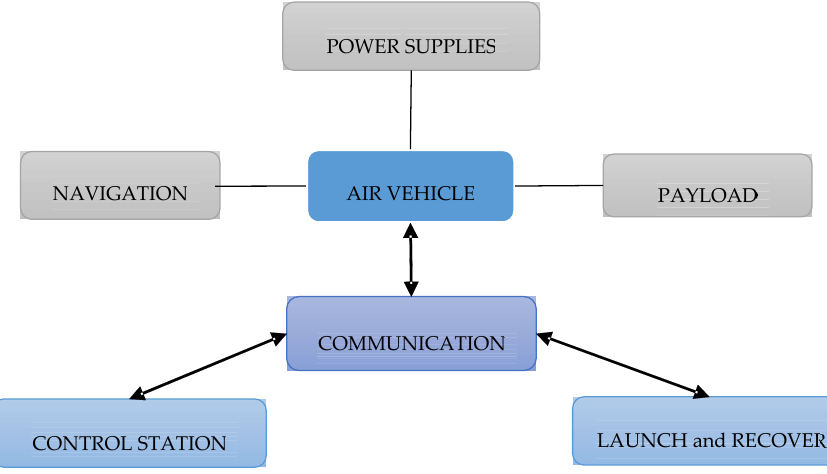
Figure 2. Functional structure of an UAV.